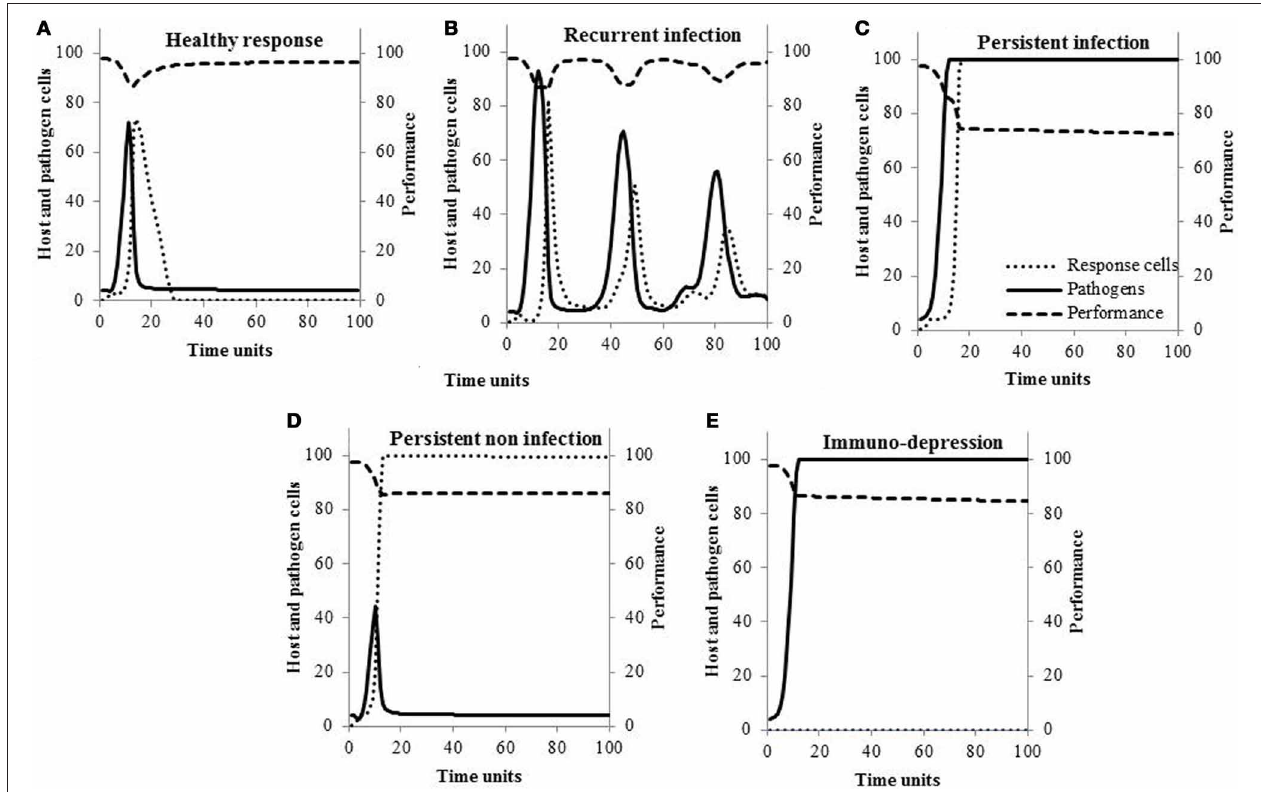
FIGURE 1 | Typical changes in the within-host concentrations of pathogens, response cells, and hosts performance according to the scenario of response to